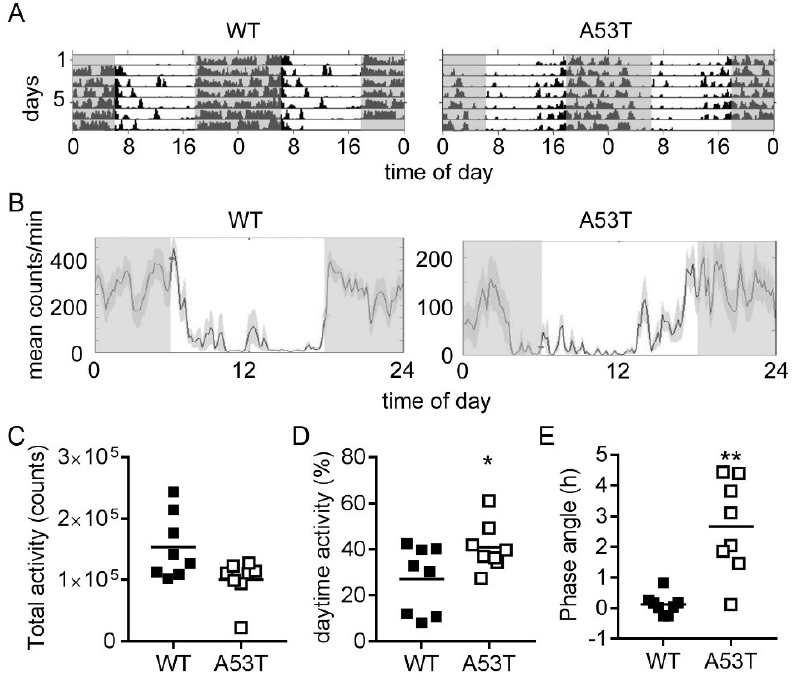
Figure 3. Analysis of locomotor activity in a 12 h light–12 h dark (LD 12:12) photoperiod. ( A ) Double-plotted actograms of spontaneous locomotor activity in LD 12:12 from representative WT and A53T mice. Grey shading indicates periods of darkness; ( B ) Representative cumulative activity profiles of WT and A53T mice under LD 12:12 conditions. Grey shading indicates periods of darkness. Note that the onset activity in the WT mouse is tightly coupled to the onset of the dark phase, whereas the A53T mouse becomes active during the second half of the light period. Graphs show the ( C ) total activity, ( D ) daytime activity, and ( E ) phase angle of entrainment. A positive phase angle indicates onset of activity prior to lights off; n = 8 mice per genotype; *: p < 0.05, **: p < 0.01, Mann–Whitney test.